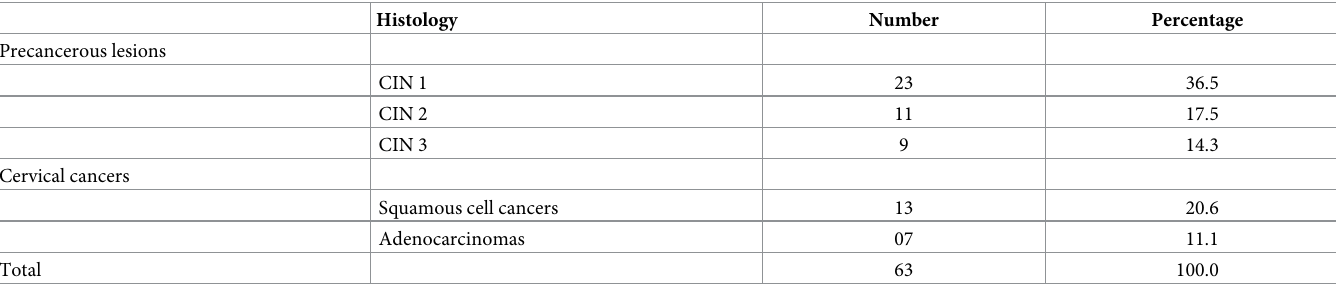
Table 3. Results from histological examinations for screened